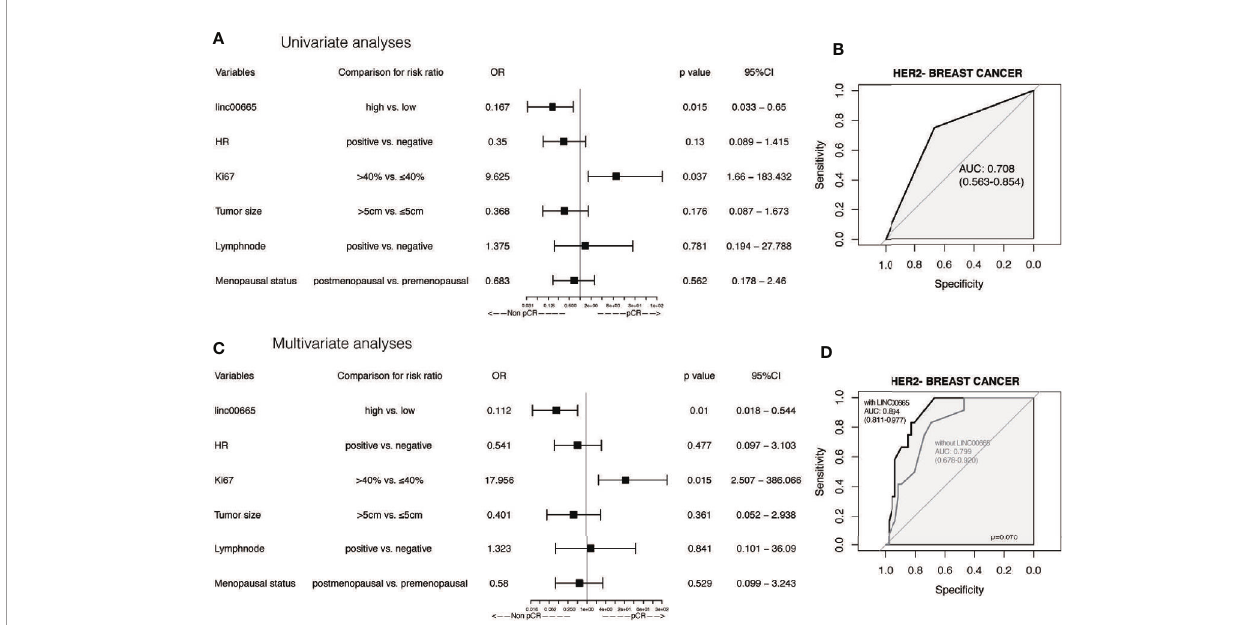
FIGURE 4 | The predictive value of Linc00665 expression in pCR in HER2-negative patients (A) Univariate logistic regression analysis of potential predictive markers HER2-negative patients; (B) Performance of Linc00665 expression in predicting pCR evaluated by ROC in HER2-negative patients; (C) Multivariate logistic regression analysis of potential predictive markers in HER2-negative patients; (D) ROC of multivariate logistic regression including clinicopathological factors with or without Linc00665 expression in HER2-negative